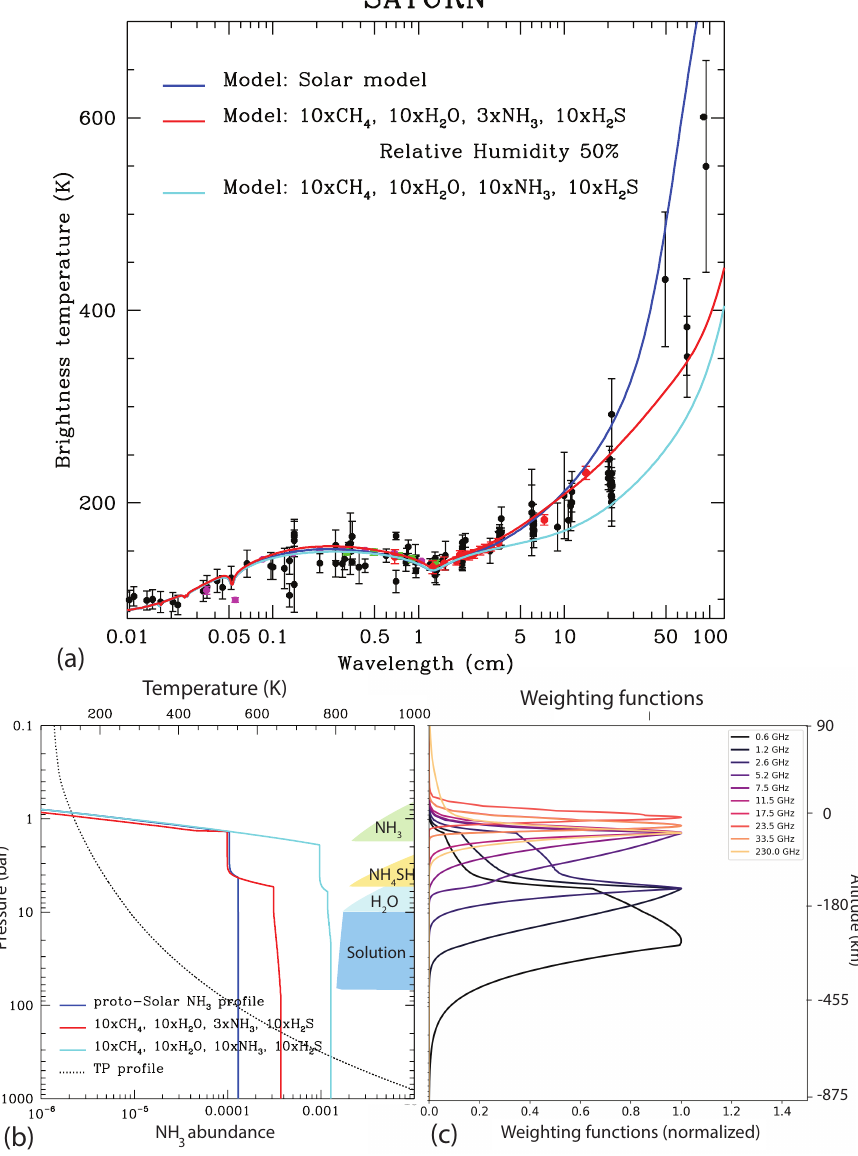
Figure 11. ( a ) Saturn’s disk-averaged brightness temperature as a function of wavelength.